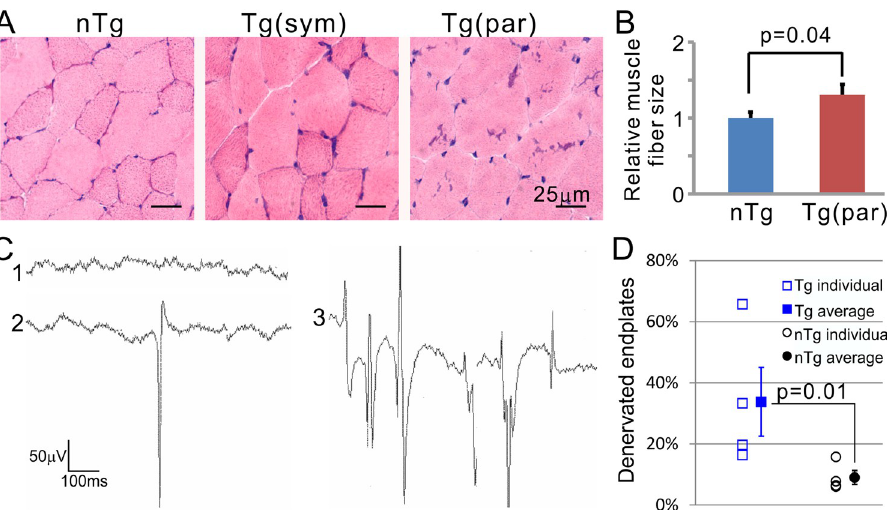
Fig 8. Denervation at the neuromuscular junction. (A) Examples of cross-sections of gastrocnemius muscle from 12-month old nTg (left), 10-month old (middle), and 12-month old paralyzed TDP-43 Tg mice (right). (B) Quantification of muscle fiber cross-section sizes. Muscle sizes from individual animals were averaged. The average values from four animals were further averaged and depicted. Error bars are standard errors. The p values were obtained by comparing the nTg with the Tg mice using student t test. (C) Examples of electromyographic (EMG) traces from an nTg mouse (trace 1) and a paralyzed Tg mouse (trace 2 and 3). (D) Quantification of denervated muscle endplates. n = 4 in both Tg and nTg groups. Statistical comparison between the Tg and nTg groups was conducted using Wilcoxon Non-parametric method.